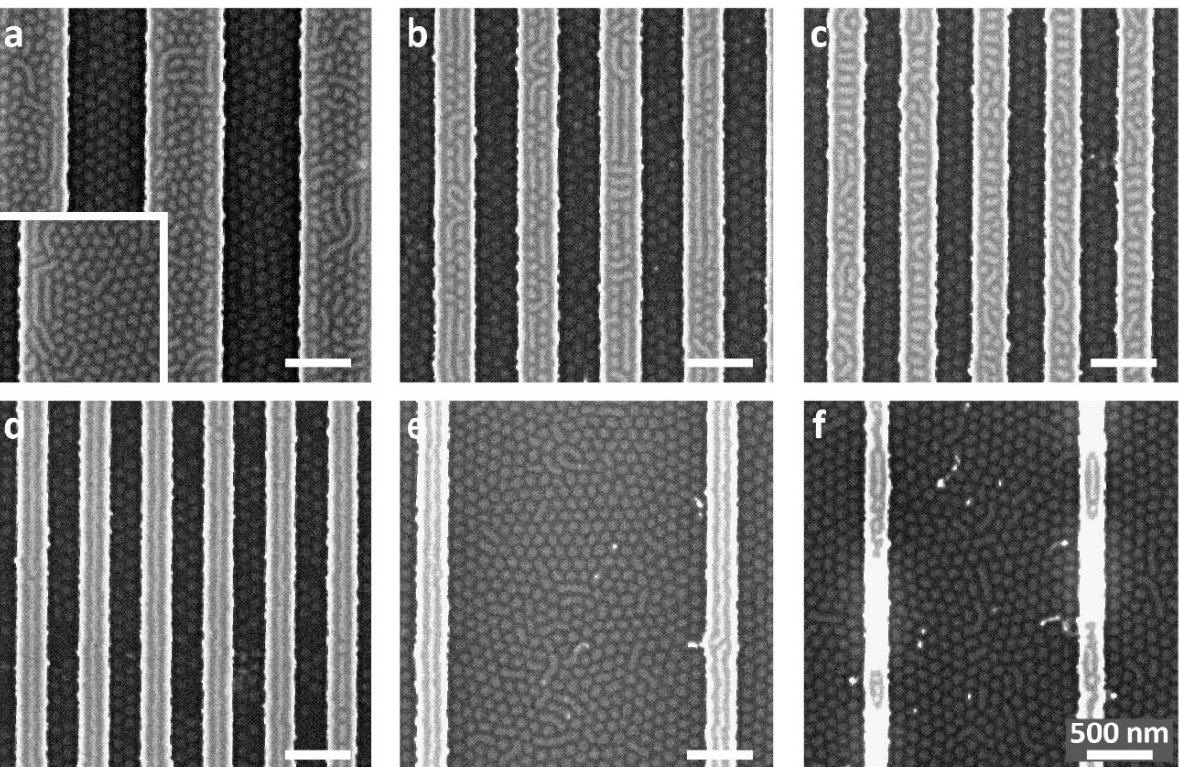
Figure 2. SEM images of samples with nominal 15 nm-thick BCP film annealed over a topographically patterned substrate featuring 38 nm deep trenches and variable trench/plateau widths: ( a ) 600/600 nm, ( b ) 320/320 nm, ( c ) 280/280 nm, ( d ) 240/240 nm, ( e ) 2000/240 nm, and ( f ) 1500/160 nm. Inset in ( a ) shows the edge of the patterned area. All scale bars represent 500 nm.